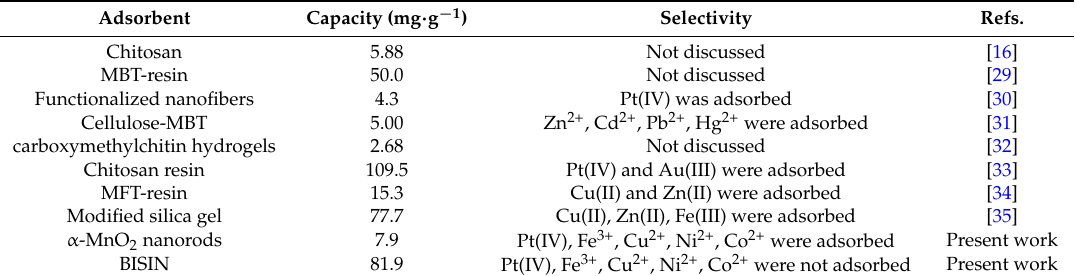
Table 3. Comparison of the maximum adsorption capacity and selectivity for Pd(II) with other adsorbents at room